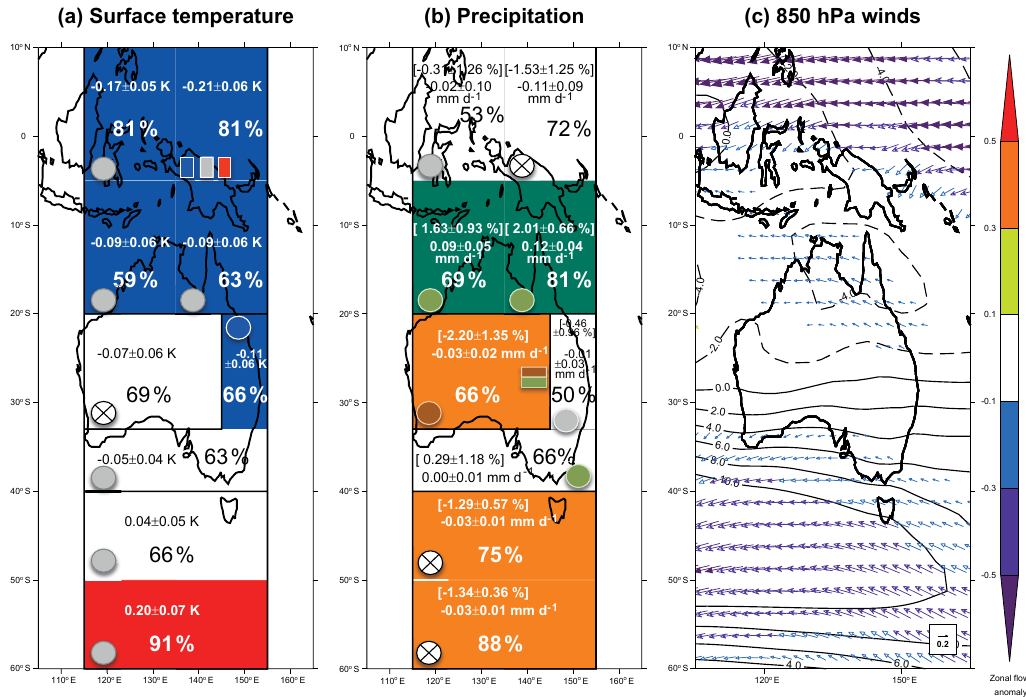
Figure 3. The ensemble and regional annual mean differences in (a) surface temperature (K), (b) precipitation (mmday − 1 and %) and (c) 850hPa circulation (ms − 1 ) for the 6ka simulations relative to the 0ka simulations. In (a) blue shading (circles) indicates lower area- averaged surface temperature and red shading (circles) indicates higher at 6ka from PMIP (proxy) estimates. In (b) , orange shading (circles) indicates lower area averaged precipitation and green shading (circles) indicates higher at 6ka from PMIP (proxy) estimates. Grey circles indicate that proxy-derived temperature and/or precipitation at 6ka was equivalent to 0ka and unshaded boxes indicate changes in temper- ature and/or precipitation that are not statistically significant ( p > 0 . 05) in the models. NB: in (a) the blue, grey and red boxes indicate that all three states for temperature are possible from the proxy data in the TNE at 6ka relative to 0ka; in (b) the orange/green rectangles denote the proxy-derived precipitation change in the northern and southern halves of the StA zone, respectively. In both (a) and (b) the values of the ensemble mean changes and the percentages of models that agree on the sign (positive or negative) of the ensemble mean temperature or precipitation differences are given. Furthermore, circles with an “X” through the middle indicate no proxy data available (both temperature and precipitation). In (c) solid and dashed contour lines indicate mean westerly and easterly flow (respectively) in the 0ka simulations and the overlaid arrows show vector wind anomalies for 6ka relative to 0ka (arrow length and colour is proportional to wind anomaly